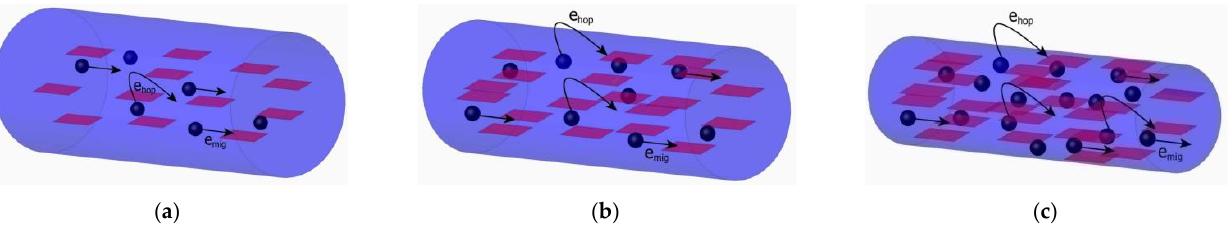
Figure 8. Mechanism of charge transport in activated carbon fabric [24] at ( a ) 800 °C, ( b ) 1000 °C, and ( c ) 1200 °C.